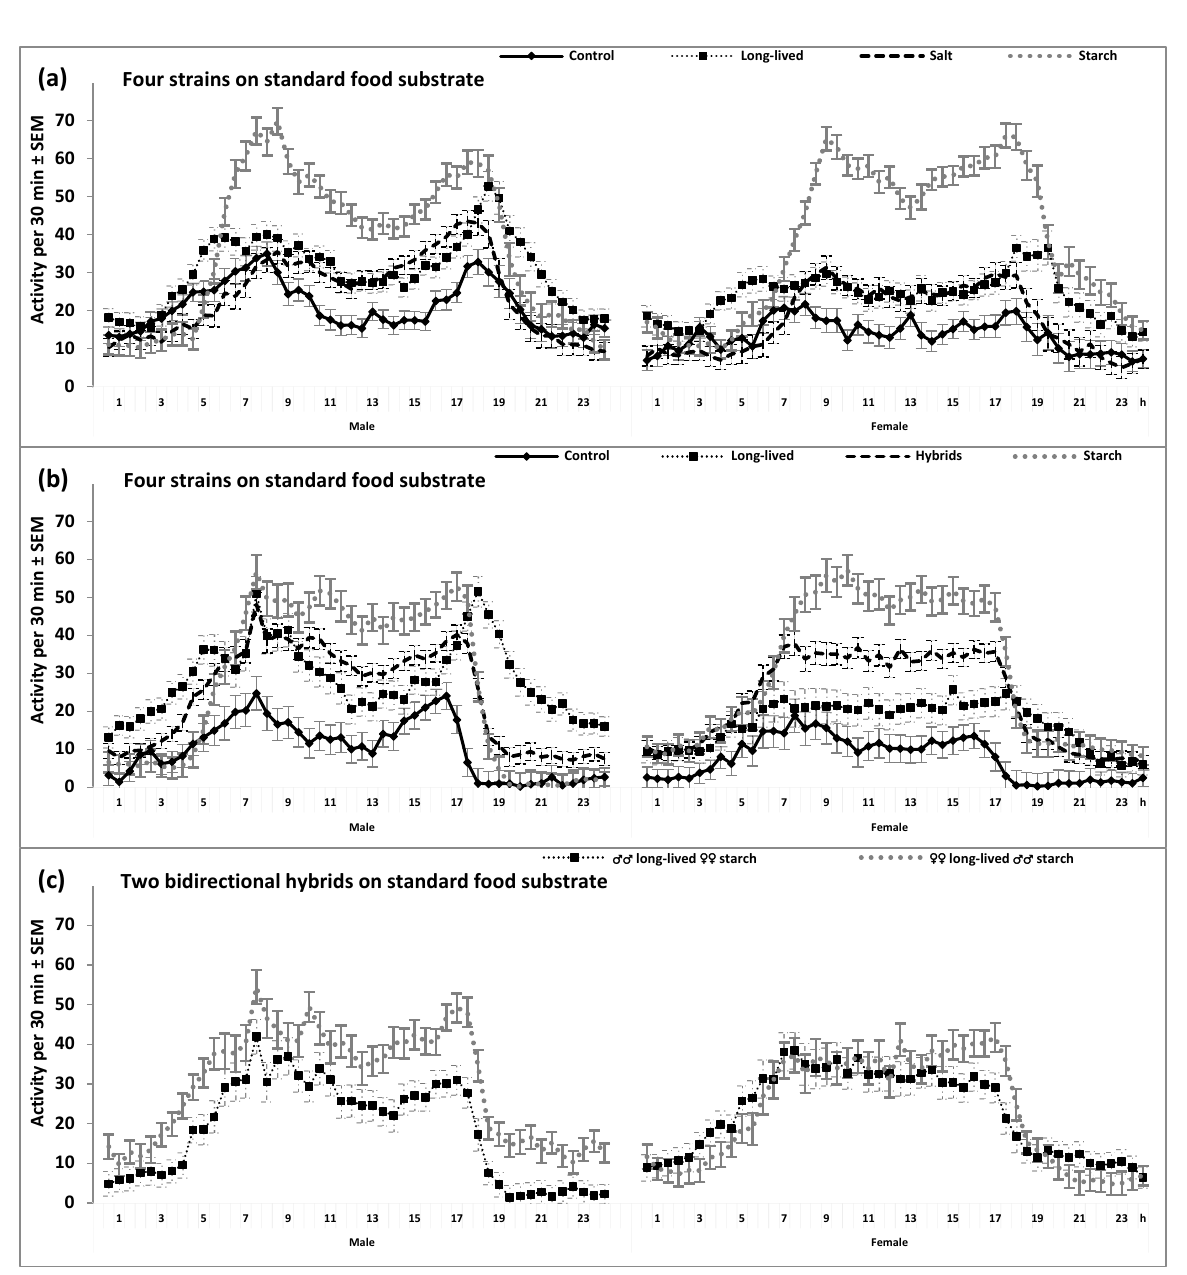
Figure 1. The 24 h patterns of locomotor activity. Locomotor activity was defined as the number of beam crossings per 30 min intervals. SEM: Standard error of mean of strain-averaged locomotor activity on 30 min intervals of the 24 h cycle (calculated from data obtained on one min intervals of the 2nd to the 4th day of the recording in constant darkness). ( a ). From the results of two two-way rANOVAs. The repeated measure was “Time point”; “Strain” was the only independent factor. Control, long-lived, salt, and starch strains: Selection was not carried out for the control strain, and three strains were selected for a longer lifespan and to adapt to adverse (salt and starch) food substrate, respectively; n = 78, 74, 78, and 65 for Male and 44, 47, 46, and 45 for Female, respectively. ( b , c ): From the results of three-way rANOVAs with another independent factor “Sex” (Male or Female). ( b ): Control, long-lived and starch strains, and the hybrids of two later strains (n = 52, 48 and 50, and 102, respectively). ( c ): F1 hybrids from bidirectional breeding: parents either long-lived ♂♂ starch or long-lived starch (n = either 50 or 52, respectively); h: Clock hour. See also Tables 1 ♀♀ ♀♀ ♂♂ and 2 for the results of two- and three-way rANOVAs illustrated in Figure 2a,b,